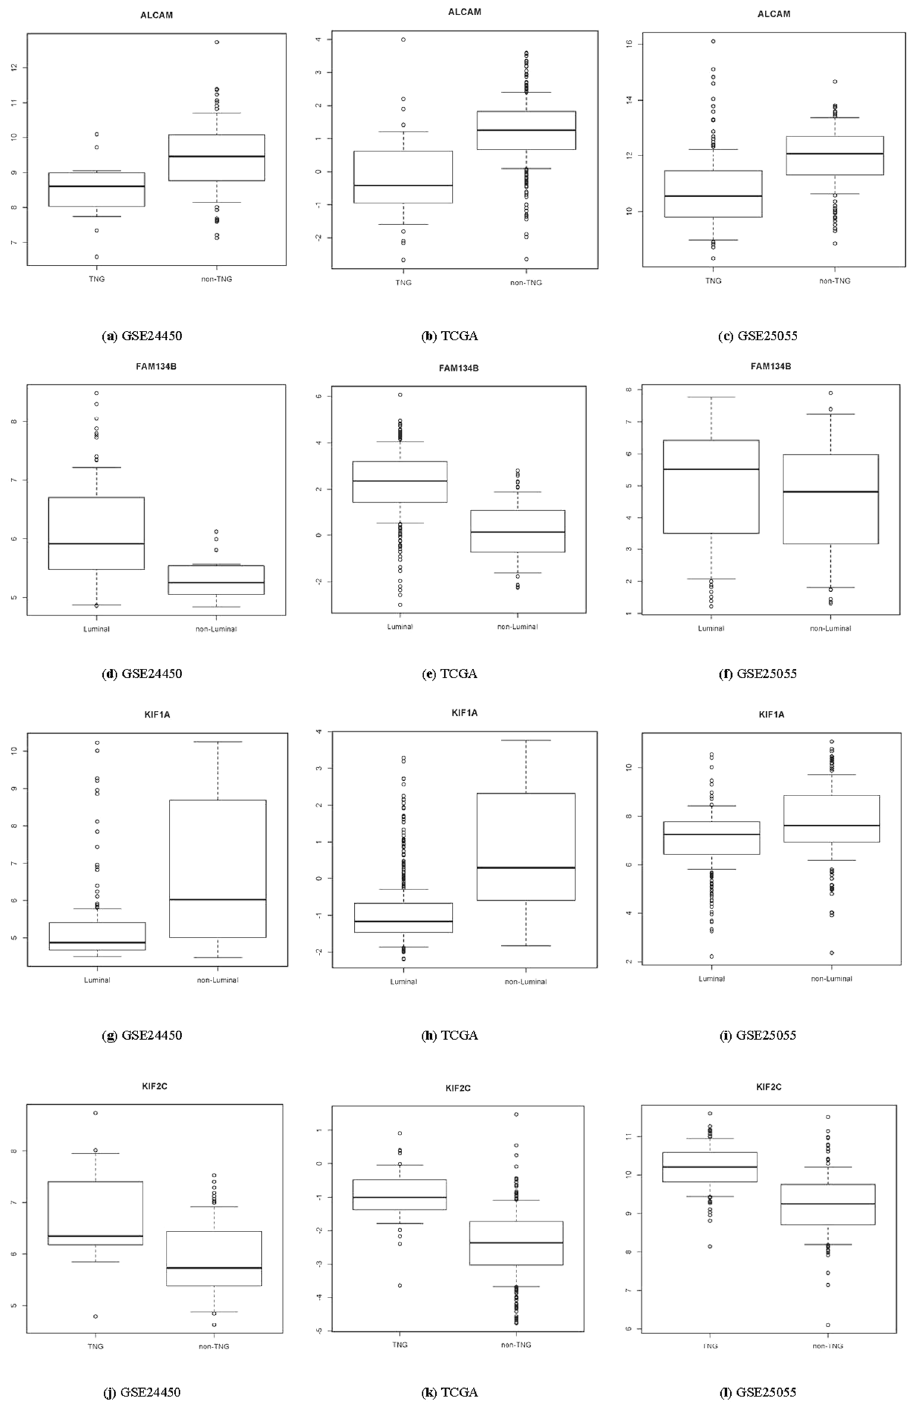
Figure 7. Breast cancers from TCGA categorized into ‘luminal vs. non-luminal’ or ‘TNG vs. non-TNG’ for each of the four pivotal diagnostic